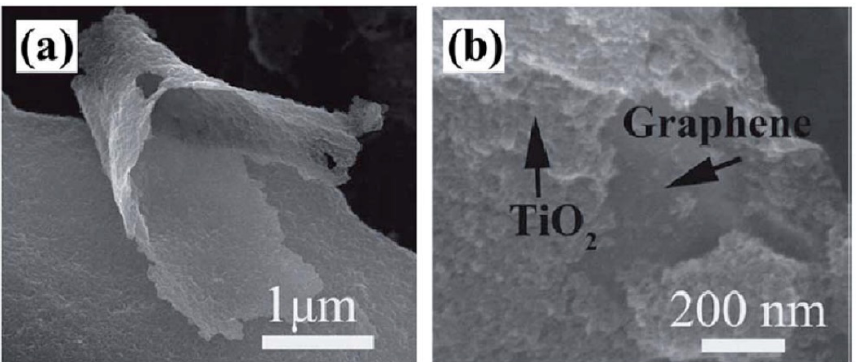
Figure 4. SEM image of 2D nanosheet sandwich-like graphene/TiO 2 . ( a ) The typical G2-TiO 2 with remarkable structural flexibility. ( b ) The TiO 2 nanoparticles intimate contact with graphene. (Taken with permission from [98]).